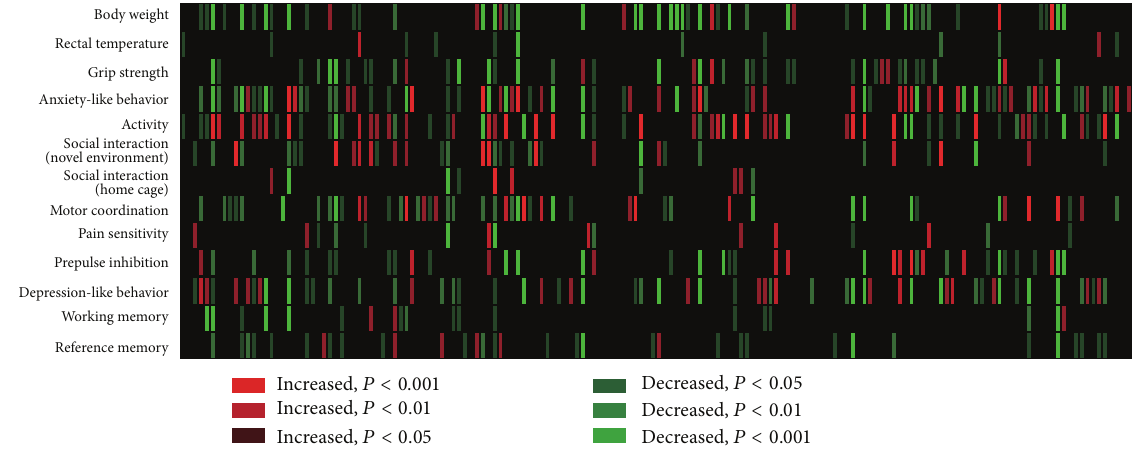
Figure 1: Heat map showing behavioral phenotypes of more than 160 strains of genetically engineered mice. Each column represents the mouse strain analyzed in the laboratory of the author’s group (unpublished data). Each row represents a behavior category assessed by the comprehensive battery of behavioral tests. Colors represent an increase (red) or decrease (green), compared between wild-type and mutant mice. Adapted from Takao et al.